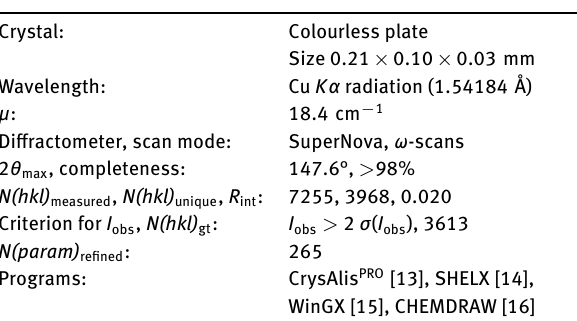
Table 1: Data collection and handling.